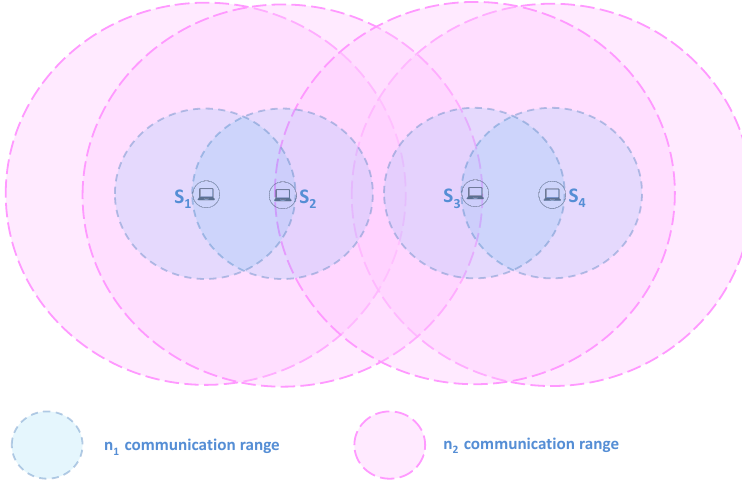
Figure 14. Example of four